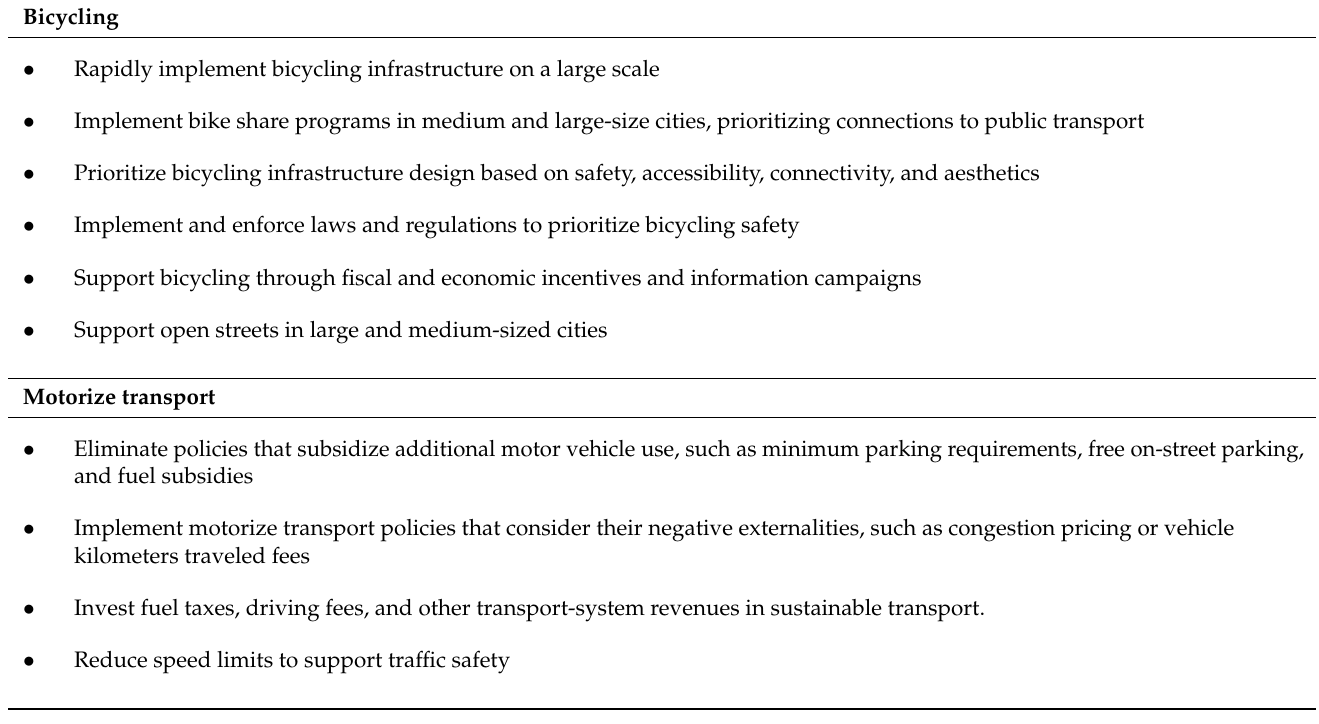
Table 3. Policy recommendations to support bicycling in